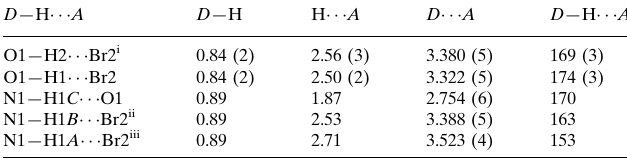
Hydrogen-bond geometry (A˚ , (cid:3)